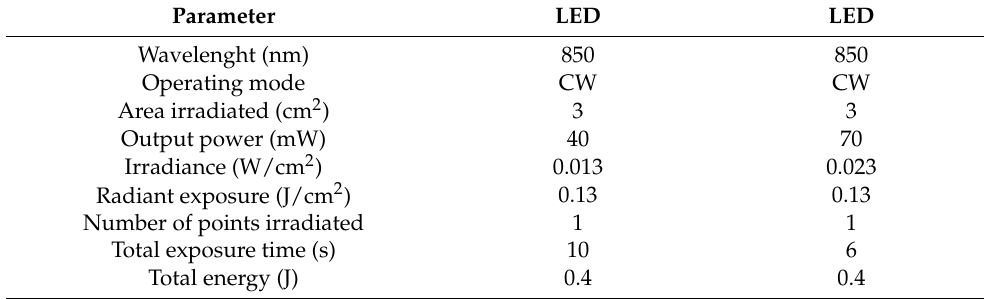
Table 2. PBM parameters